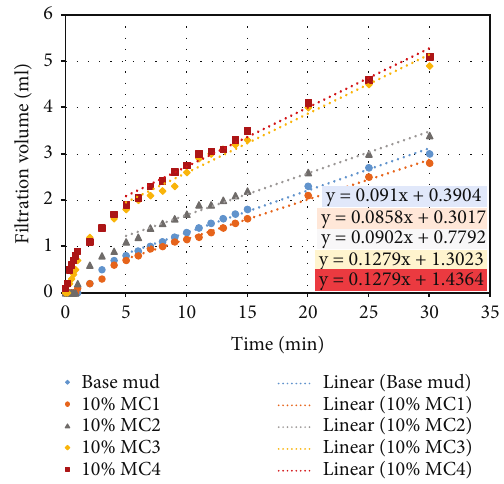
Figure 13: Filtrate volume vs time for the base mud and as function adding di ff erent cuttings in 10% concentration.